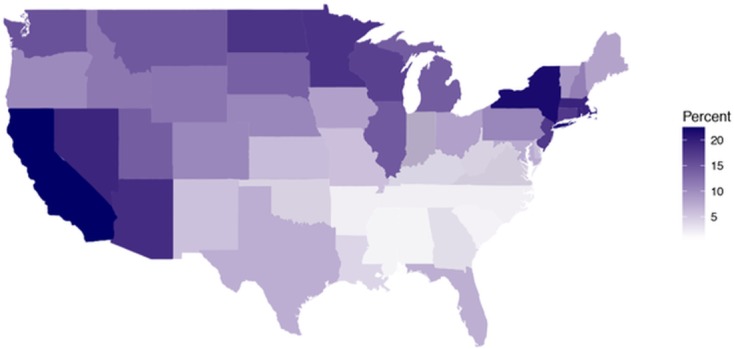
Average percent foreign born populations of the states of the continental United States.Based on censuses from 1850 (or between 1860 and 1890 for later-entry states) until 2010. Darker colors indicate higher percent foreign born populations.